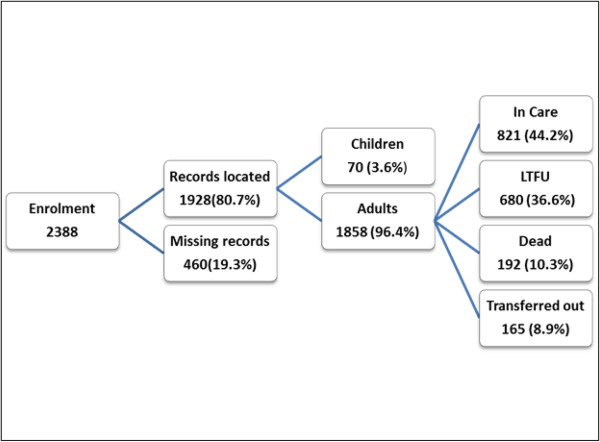
Cohort construction of participants enrolled between 2005 and 2010.